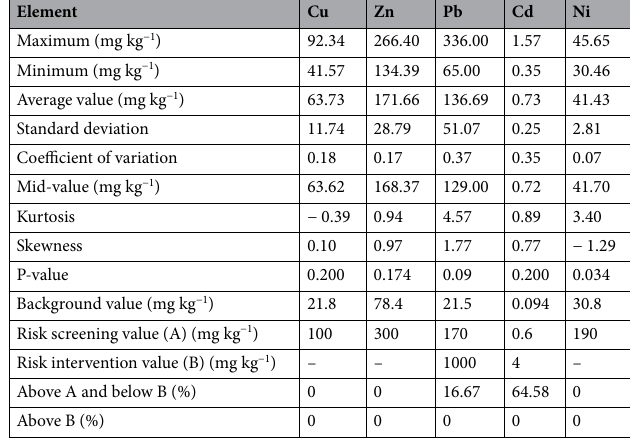
Table 4. Statistical analysis of soil lead and cadmium in Anxin